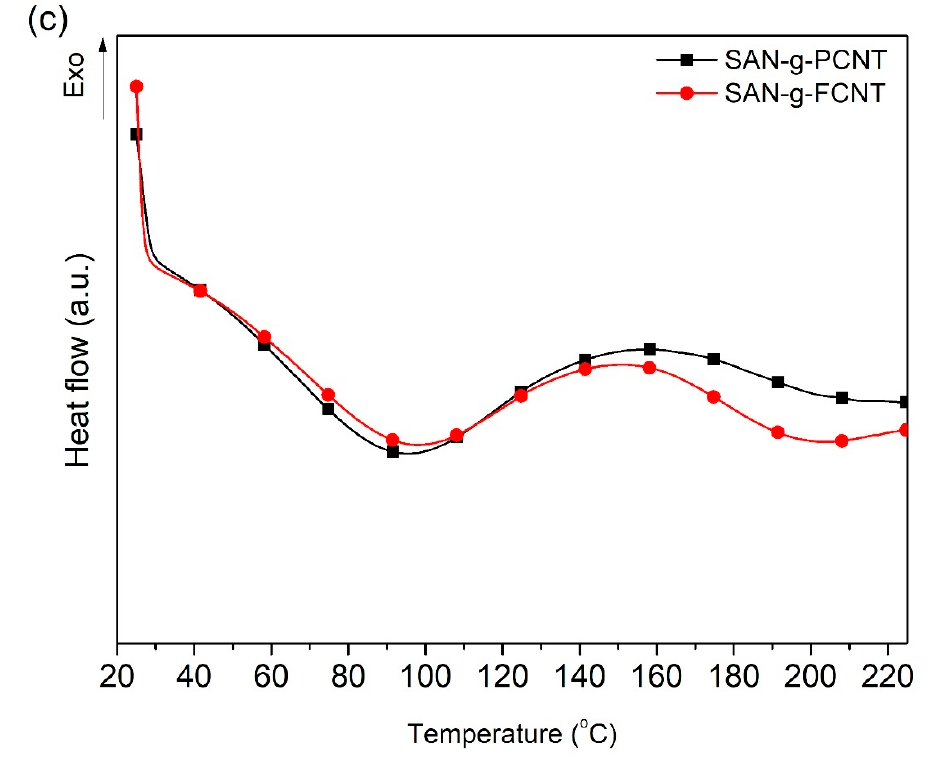
Figure 8. ( a ) TGA, ( b ) DTG, and ( c ) DSC curves for SAN-g-PCNT and SAN-g-FCNT.